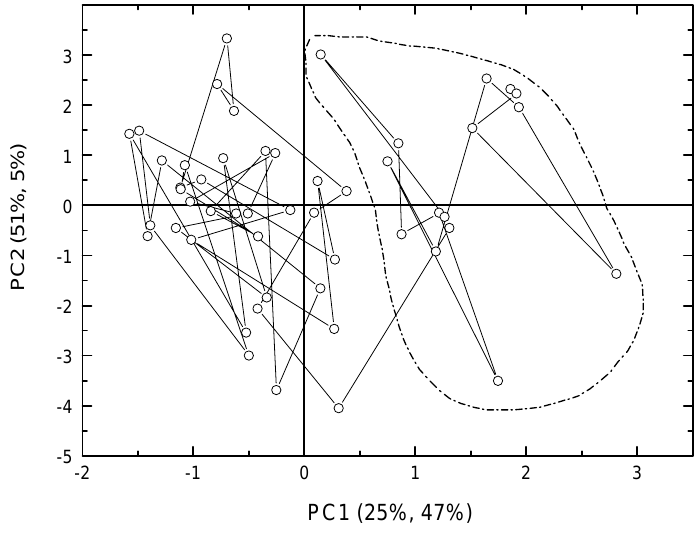
Figure 12. PLS-1 score plot of all samples in test mixtures of key odorants containing p-cresolate at pH 8. Samples (15 samples) with high concentrations (5 × 10 -4 - 10 -3 M) of n-butyrate are surrounded by dashed line. Full cross validation was used and six electrodes were sufficient.